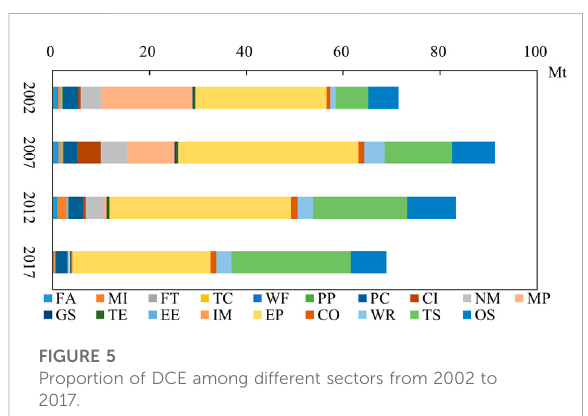
FIGURE 5 Proportion of DCE among different sectors from 2002 to